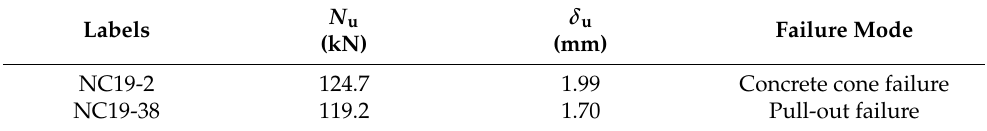
Figure 4. Load–displacement curves of specimens. Table 2. Experimental results. Table 2. Experimental results.